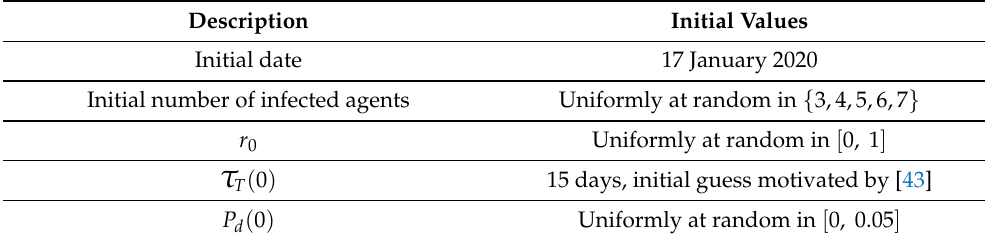
Table 3. Initial